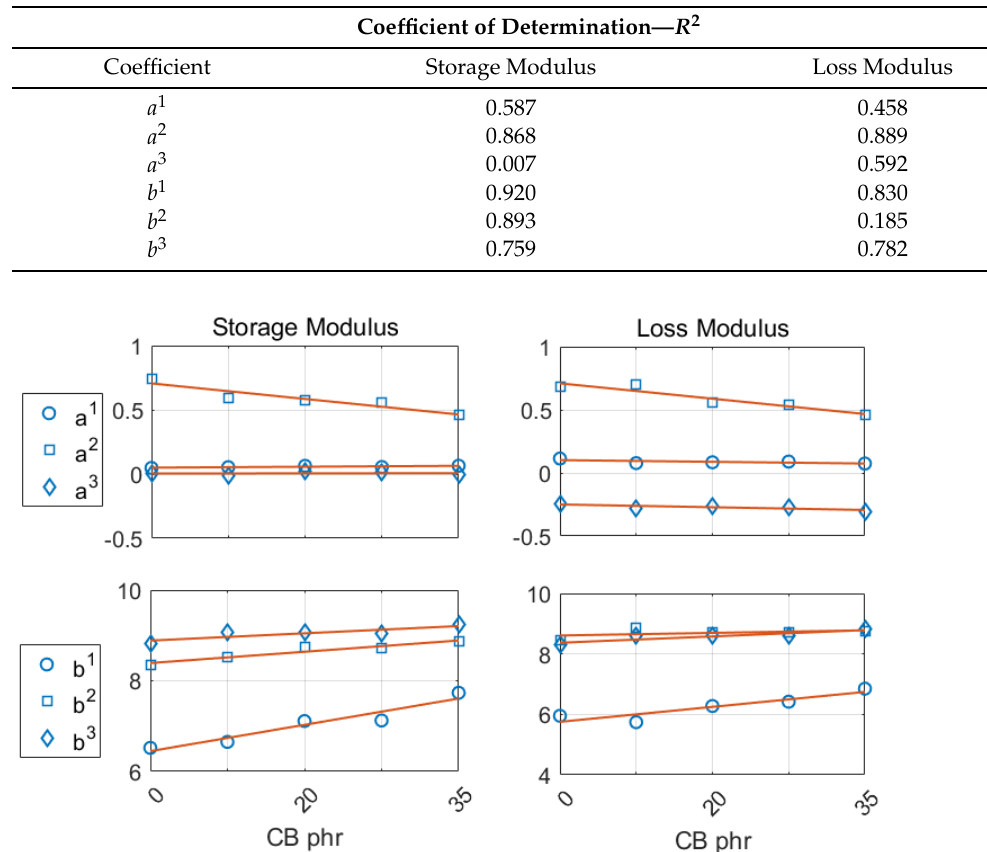
Figure 11. Linear regression between the coefficients of the linear polynomial equations ( y = ax + b ) and the CB concentration. Linear equations reproduce the linear sections of storage and loss modulus, respectively (see Figure 4). Coefficients ( a 1 , b 1 ) , ( a 2 , b 2 ) , ( a 3 , b 3 ) fit the first, second and third linear sections of the two modulus curves, from left to right